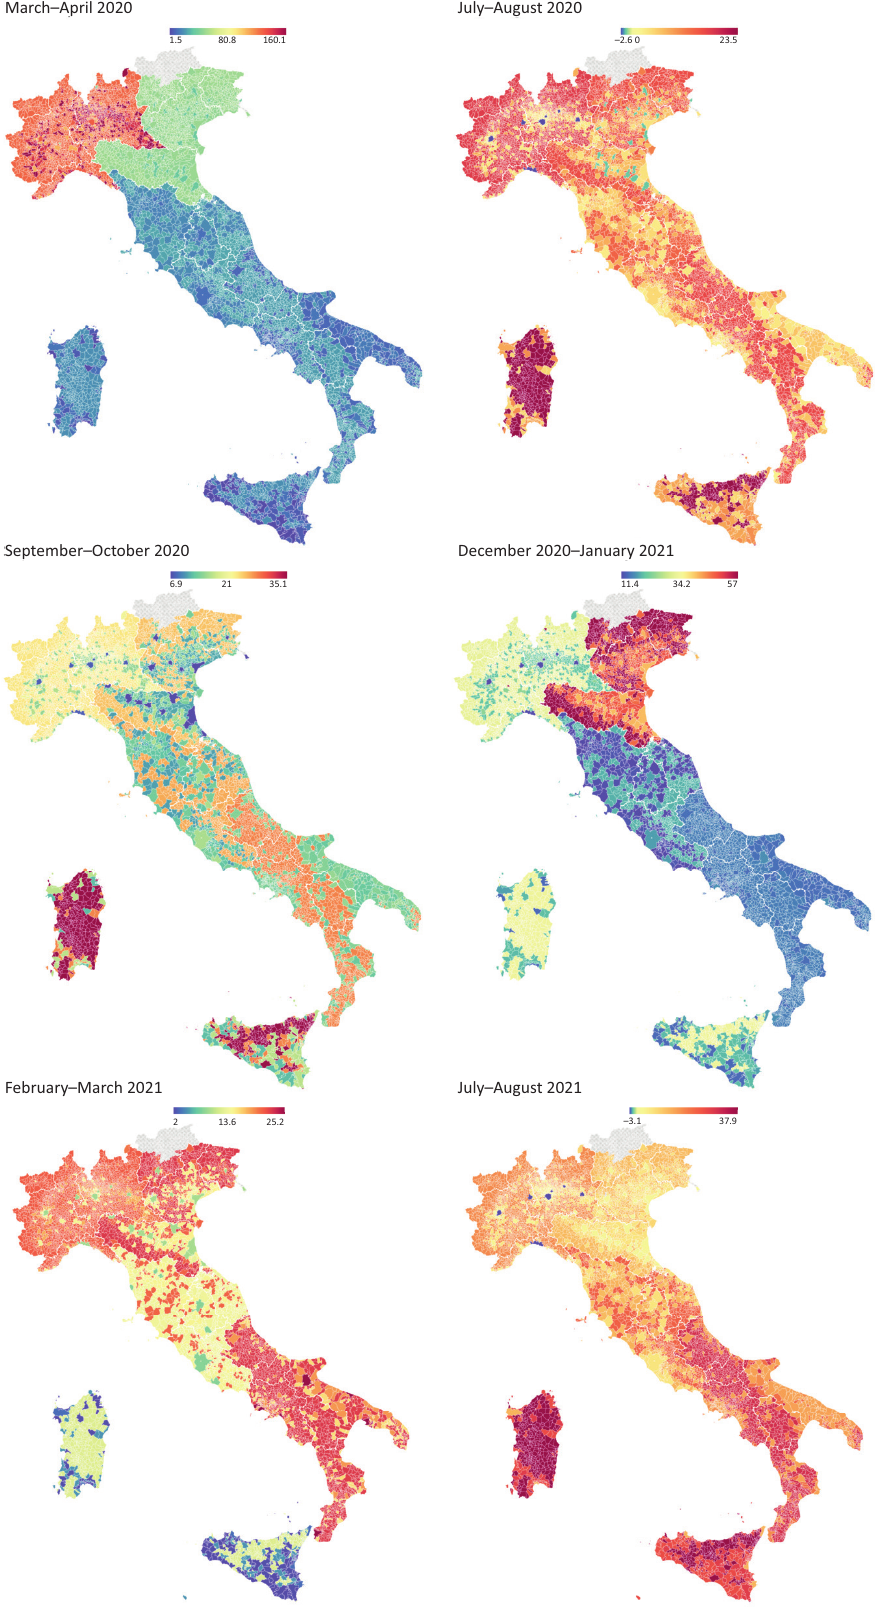
Figure 2. Imputed excess mortality rates at the municipal level from March–April 2020 to July–August 2021. Notes: Color gradients indicate wave‐specific severity; missing information for the province of Bolzano. Source: Authors’ work based on Istat (2022) mortality